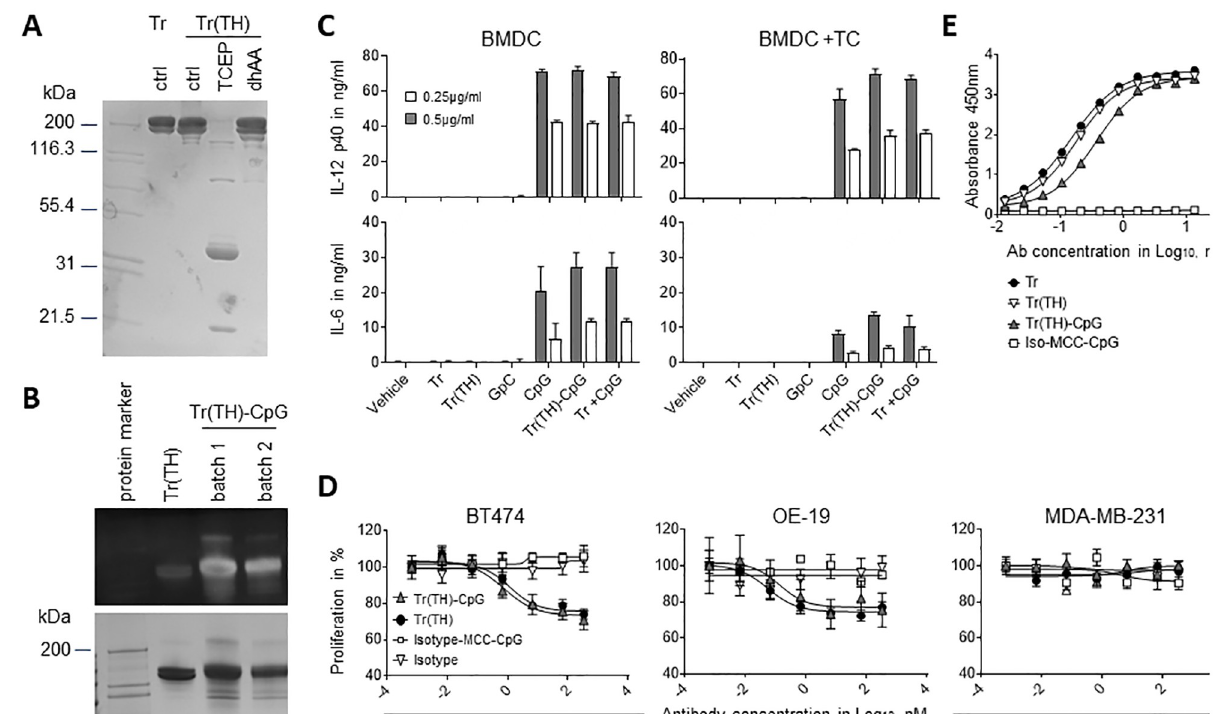
Fig 5. Generation and in vitro evaluation of TH-Trastuzumab-MCC-ODN conjugate. (A) SDS-PAGE analysis of TH-Trastuzumab in native, reduced and reoxidated form on 4–20% gel stained with SimplyBlue. (B) SDS-PAGE analysis of TH-Trastuzumab-MCC-CpG conjugates under non- reducing conditions. The gel was sequentially stained with SYBR Gold (top) to visualise the ODN content, then with SimplyBlue (bottom) for protein content. The Data are representative of three independent experiments. (C) The immunostimulatory activity of TH-Trastuzumab-MCC-CpG was assessed in vitro in a BMDC activation assay. 1x10 5 GM-CSF derived BMDC were stimulated overnight with free or conjugated CpG in the presence (BMDC +TC) or absence (BMDC) of 4x10 5 B14.3 HER2 tumor cells. IL-12p40 and IL-6 levels in the culture supernatants were determined by sandwich ELISA. Samples were normalised for concentration of CpG of 0.5 μ g/ml or 0.25 μ g/ml. Data are mean ± SD of three technical replicates and is representative of two independent experiments. (D) The anti-proliferative effect of TH-Trastuzumab-MCC-CpG was assessed in the MTS assay. Trastuzumab-sensitive human tumor cell lines BT474 and OE19, and the HER2-negative/low Trastuzumab-resistant control cell line MDA-MB-231 were cultured for 48 h with antibody or antibody-MCC-CpG conjugate. The antibody: ODN ration of the conjugates was approximately 1.6:1. The data were normalised to the proliferation of untreated control cells and expressed as percent proliferation. Data are representative of two independent experiments with individual batches of conjugates. (E) The antigen binding activity of TH-Trastuzumab-MCC-CpG was compared to unconjugated Trastuzumab in the ELISA with immobilised recombinant human HER2. The ODN: antibody ratio of the conjugates was approximately 1.7:1. The data are representative of four independent experiments with individual batches of conjugates. dhAA: haloalkane dehalogenase; TCEP: Tris (2-carboxyethyl)